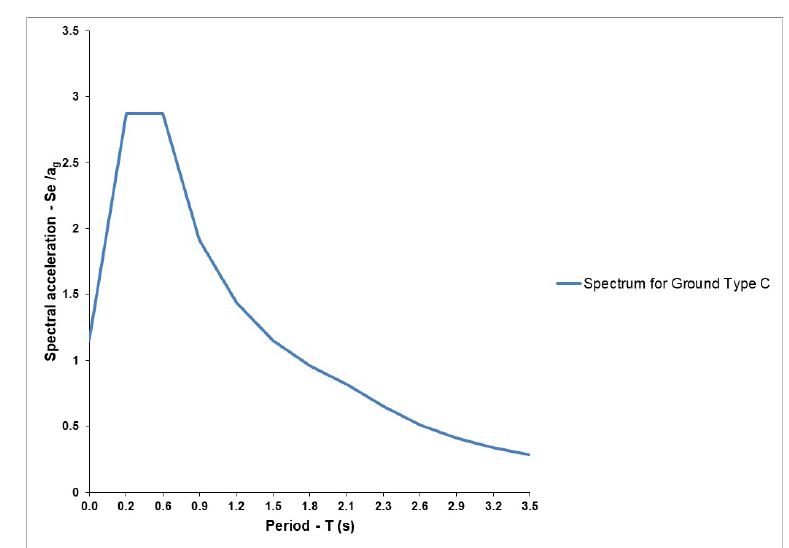
Figure 8. Elastic response spectra for Sarajevo according to Eurocode 8 for 0.1 g.